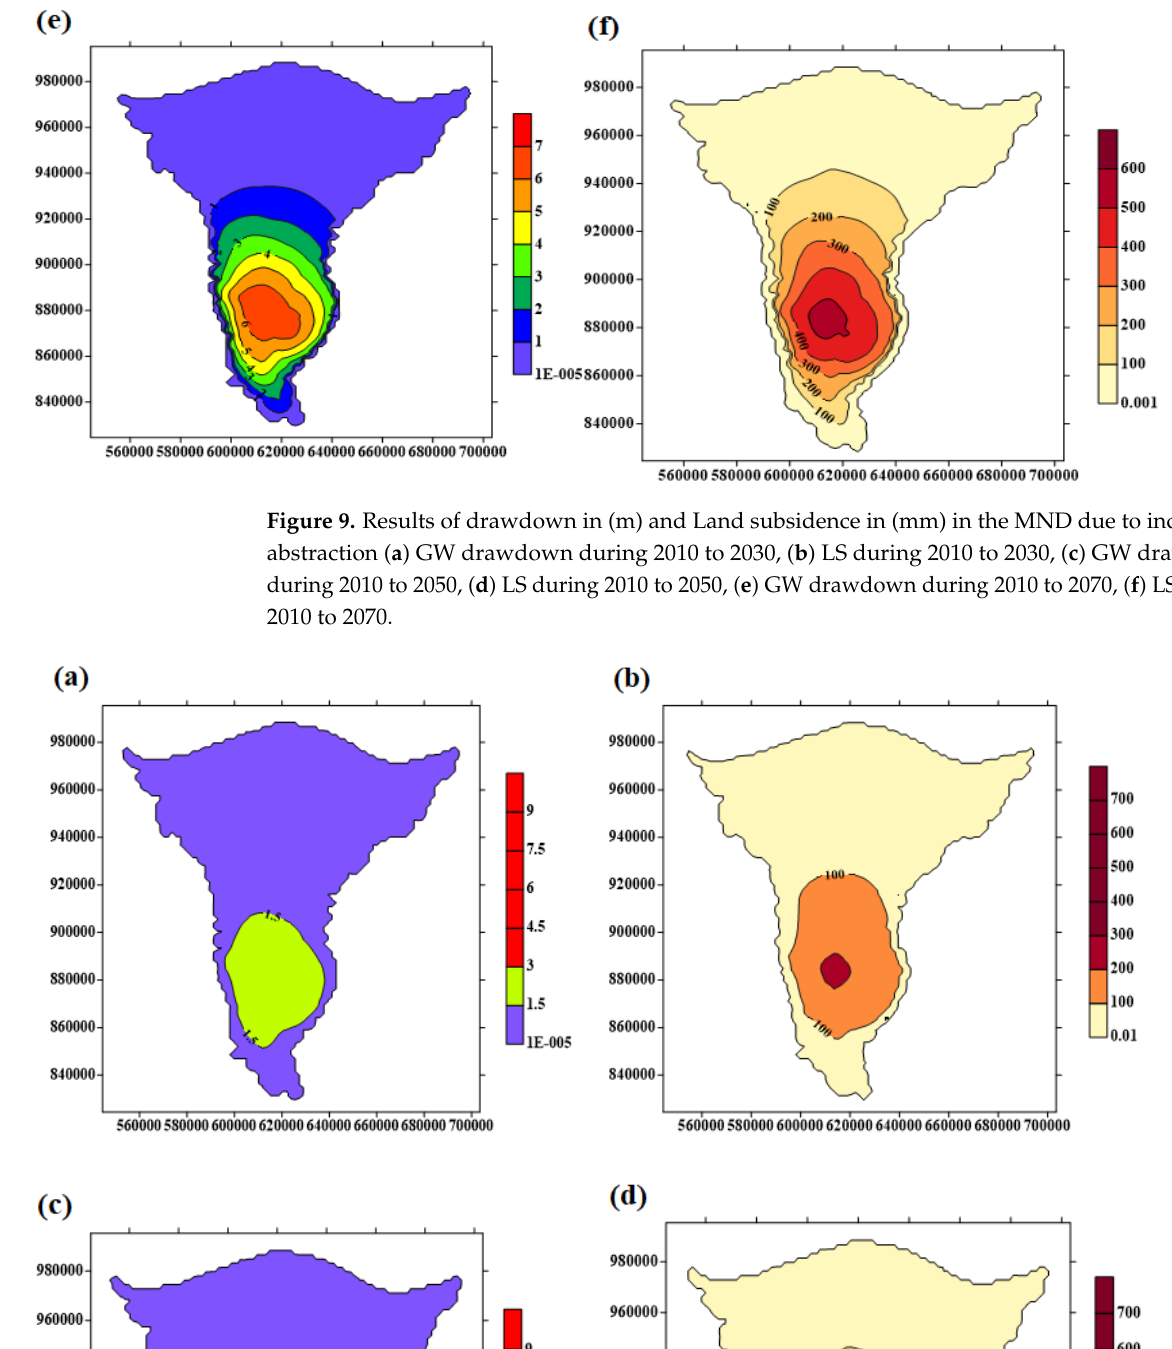
down is represented as concentric circles because of the intensive concentration of pump- ing wells in middle zone of the study area. In addition, the results indicated that the area with the highest LS rates is the core of the MND as shown in Figure 10.